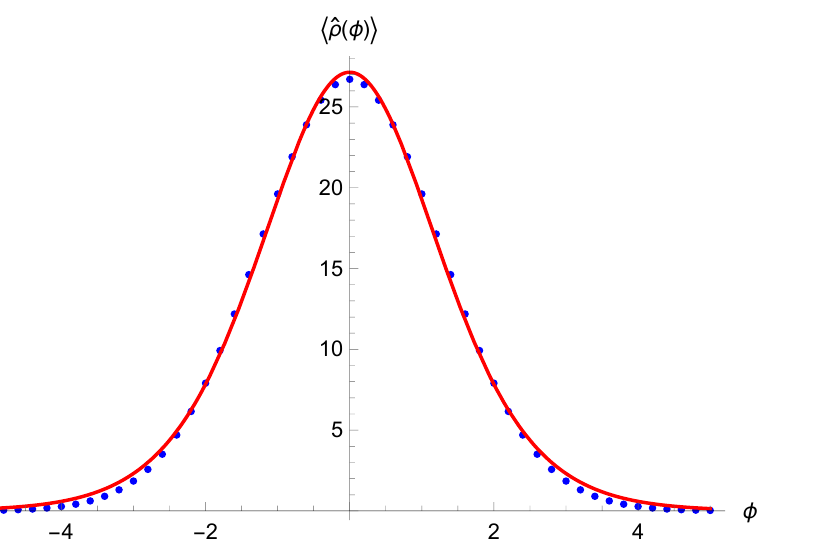
Figure 5. The expectation value of the energy density as function of time (blue dots), fitted with a function in accordance with the semiclassical evolution (continuous red line).